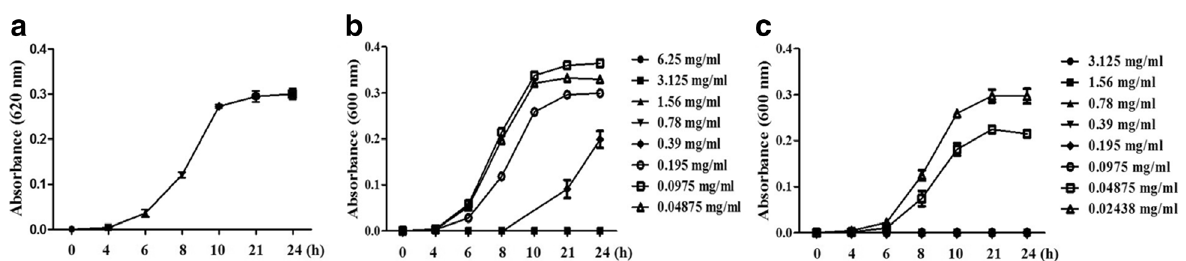
Fig. 2 The growth curves of S. typhimurium treated with Colla corii asini extract. We quantitatively evaluated the potency of the Colla corii asini ethanol extract by determining the MIC. a The growth curve of S. typhimurium with vechicle. b The growth curve of S. typhimurium with Colla corii asini ethanol extracts. c The growth curve of S. typhimurium with ampicillin. We calculated an MIC value of 0.78 mg/ml by using the tube dilution method. The growth of S. typhimurium was reduced by treatment with the Colla corii asini ethanol extracts. We calculated an MIC value of 0.78 mg/ml by using the tube dilution